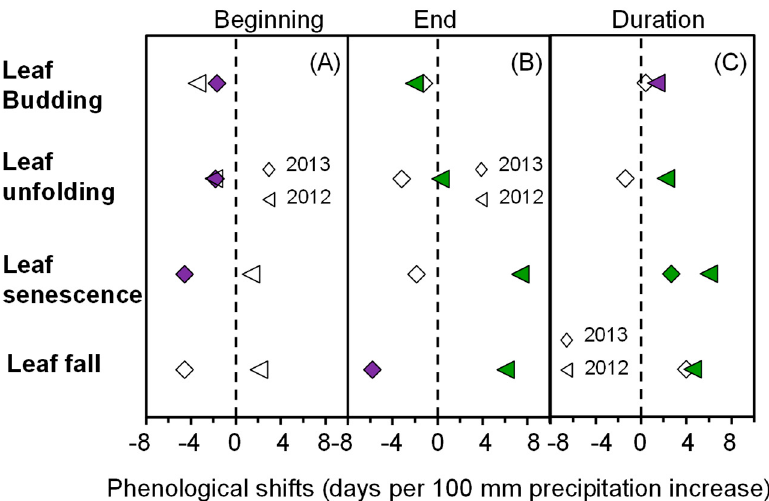
Figure 6. Slope of the linear regression line between phenological events, Beginning ( A ), End ( B ), Duration ( C ), and the simulated increase in precipitation. Green indicates a significant correlation ( p ≤ 0.05), and purple indicates a close significant correlation (0.05 < p ≤ 0.10). A blank indicates the lack of a significant correlation.